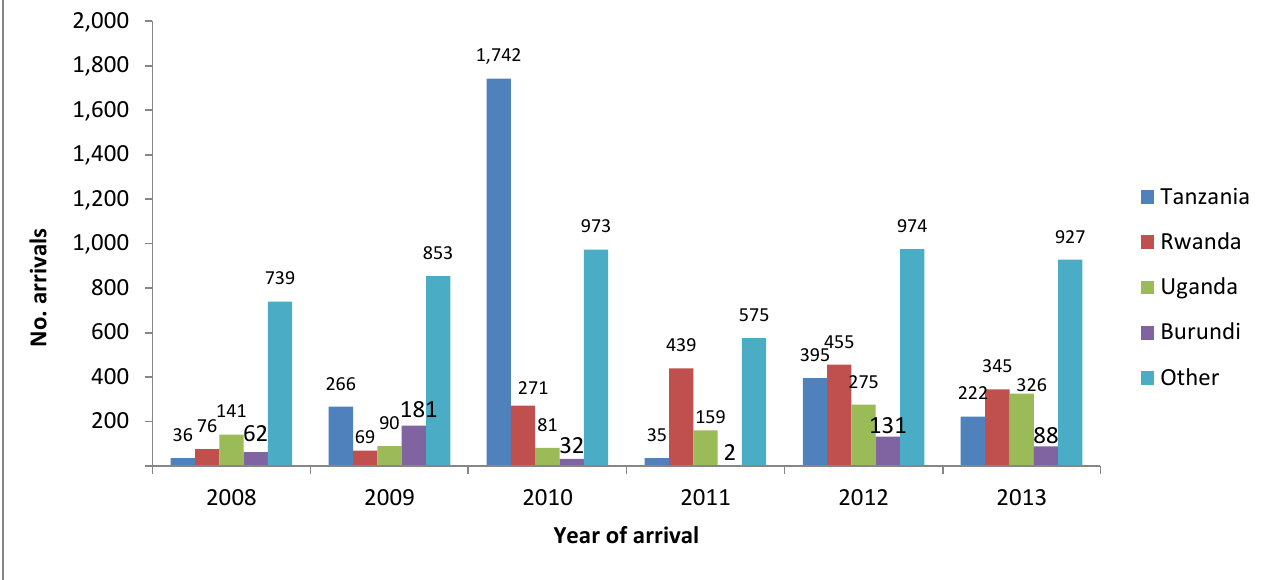
Figure 3: Congolese refugee arrivals in the US, 2008 – 2013 (n=10,960)